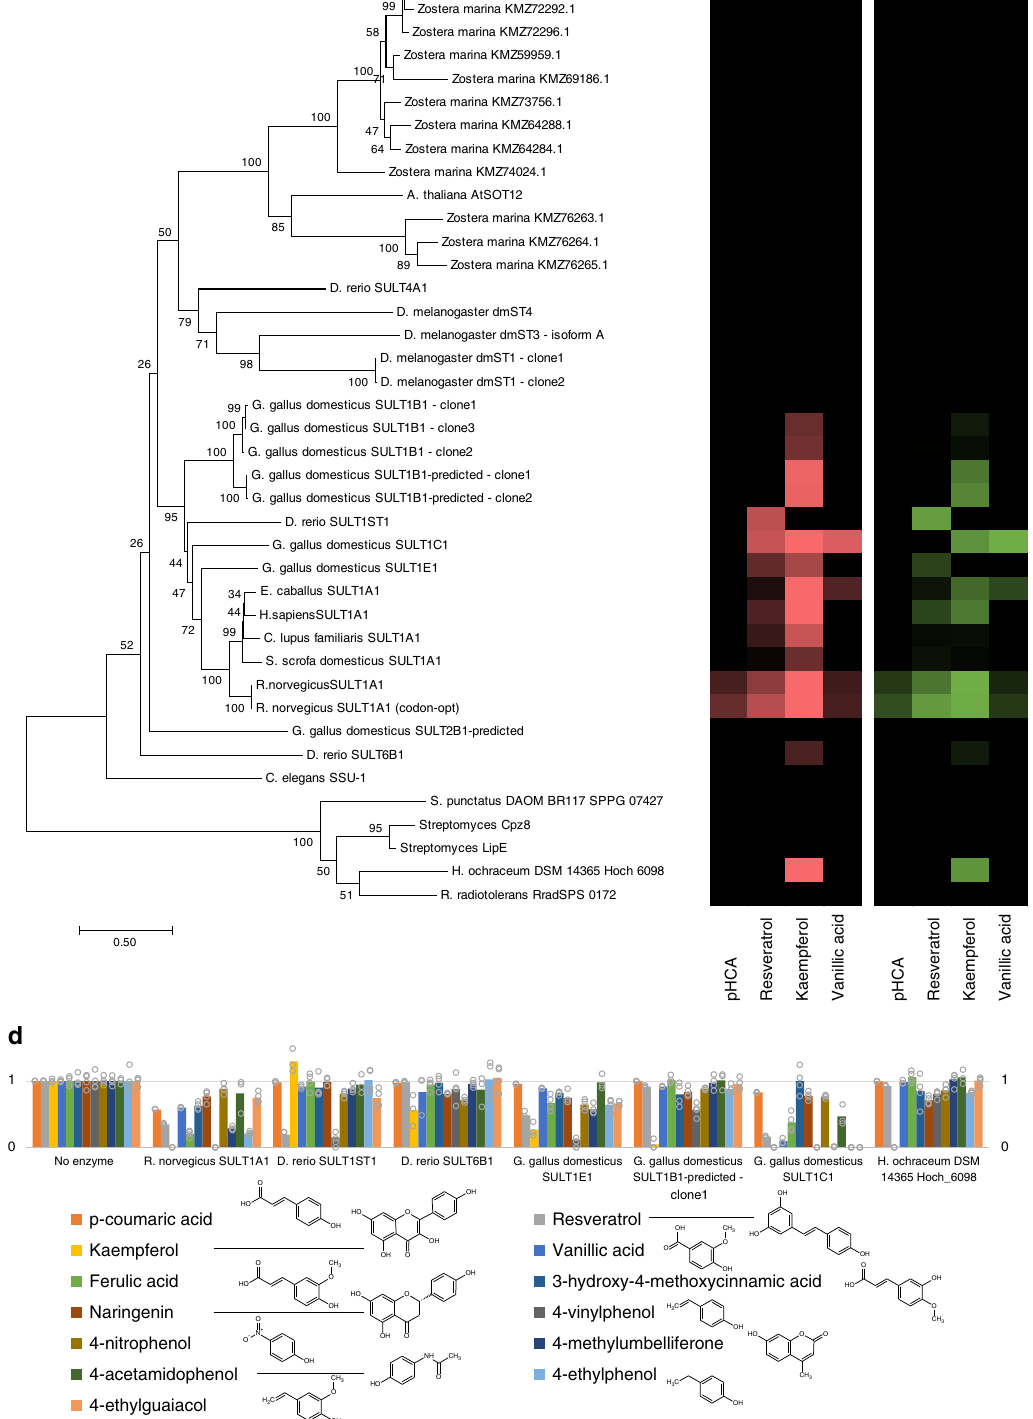
Fig. 2 Activity and relationship between screened sulfotransferases. The phylogenetic relationship a of the chosen sulfotransferases shown together with b the consumption of substrates (pHCA ( p -coumaric acid), resveratrol, kaempferol, and vanillic acid) and appearance ( c ) of product peaks. d The substrate speci fi city of selected phenol sulfotransferases when the production organisms were challenged with selected compounds ( p -coumaric acid, orange; resveratrol, light gray; kaemphferol, yellow; vanillic acid, blue; ferulic acid, light green; 3-hydroxy-4-methoxycinnamic acid, navy blue; naringenin, rust red; 4-vinylphenol, dark gray; 4-nitrophenol, golden brown; 4-methylumbelliferone, dark blue; 4-acetamidophenol, dark green; 4-ethylphenol, light blue; 4-ethylguaiacol, light brown). The height of the bars show the relative remaining amount of compounds relative to a strain that harbors an empty expression plasmid shown (as averages of individual points plotted in circles). Source data of Fig. 2d are provided as a source data fi